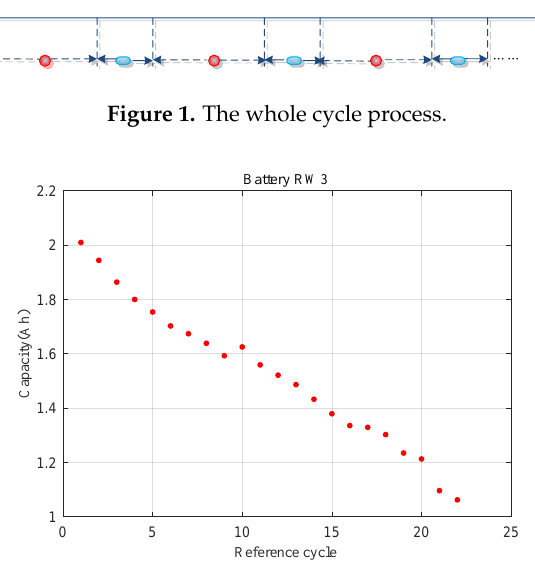
Figure 2. Capacity of battery RW3 measured at each discharge cycle.